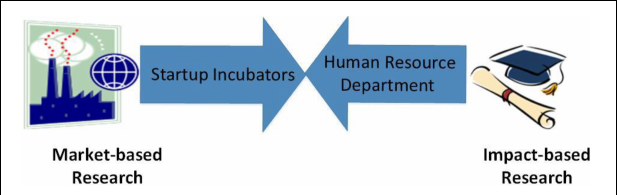
FIGURE 5 | Industry and academia integrated